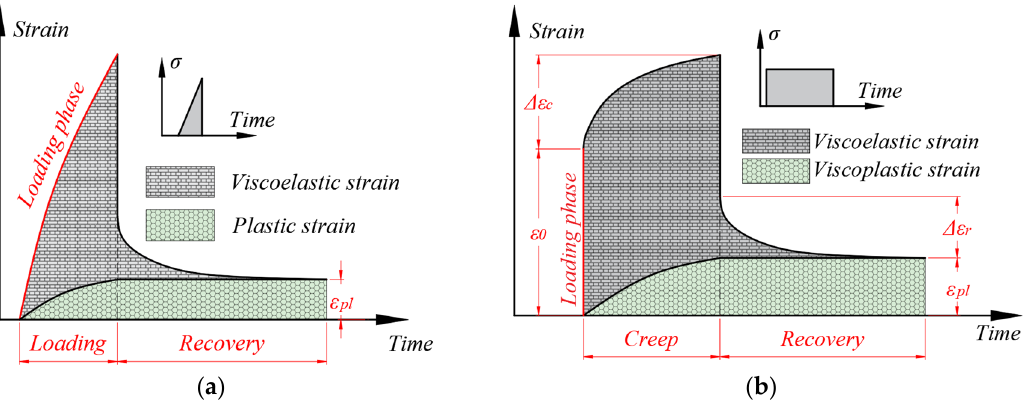
Figure 2. Schema of the expected strain response: ( a ) during a loading-recovery test; ( b ) during a creep-recovery test.